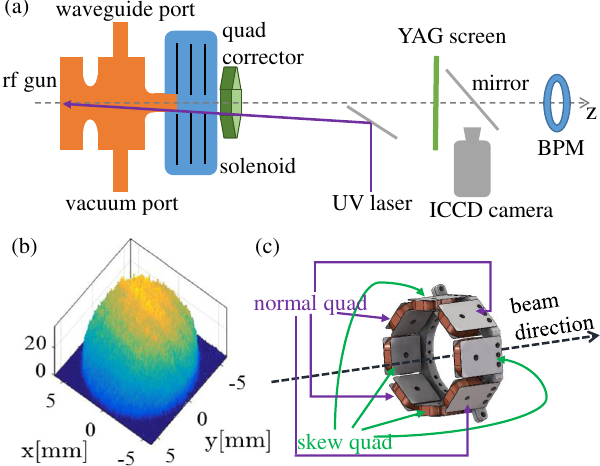
FIG. 1. The experimental setup at AWA. (a) The layout of the beam line. (b) The intensity distribution of the laser spot homogenized by the microlens arrays. (c) The design of the quadrupole